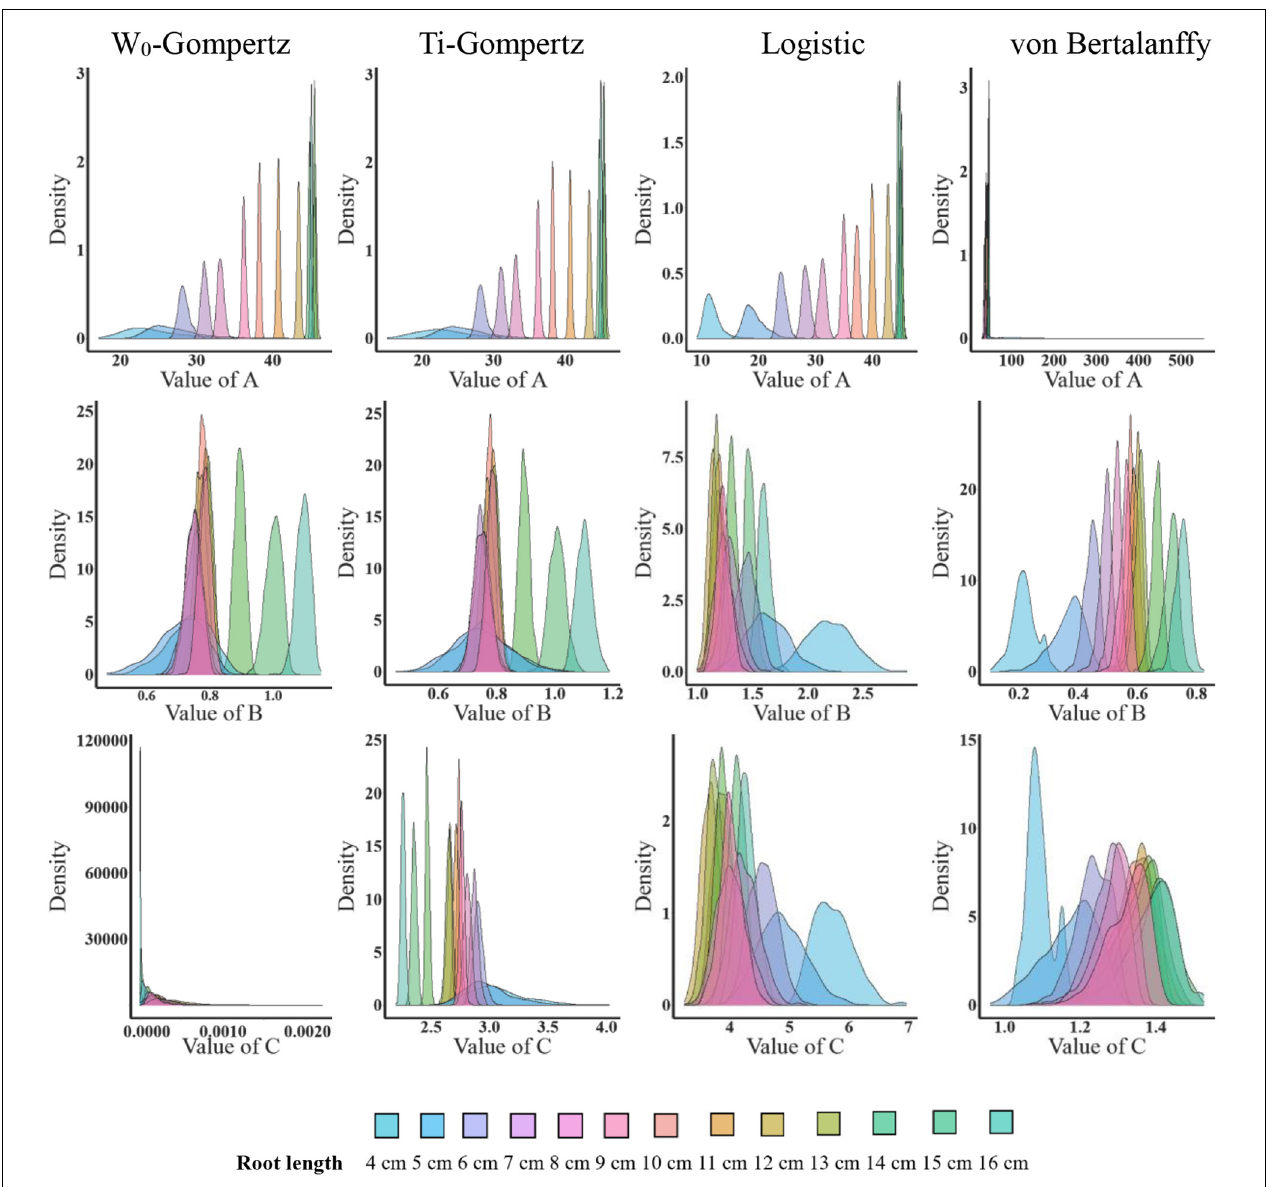
FIGURE 4 | The distribution of the parameter estimates by the bootstrap-based parameter estimation of the W 0 -Gompertz, Ti-Gompertz, logistic, and von Bertalanffy models fit to the aerenchyma percentage in rice adventitious roots of different lengths. Density is the probability density function. The nlsBoot() function in the nlstools package in R was used to obtain 1,000 bootstrap estimates for each